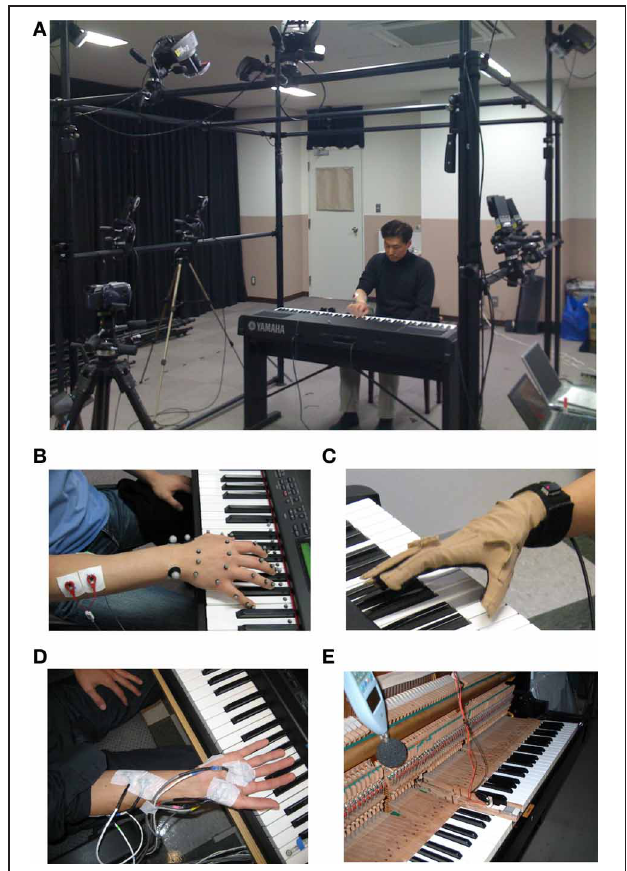
FIGURE 1 | Devises for behavioral measurements. (A) Motion capture system with high speed cameras. (B) Reflective markers for the motion capture. (C) Data glove. (D) Surface electromyography. (E) Force sensor embedded on the surface of a piano key.